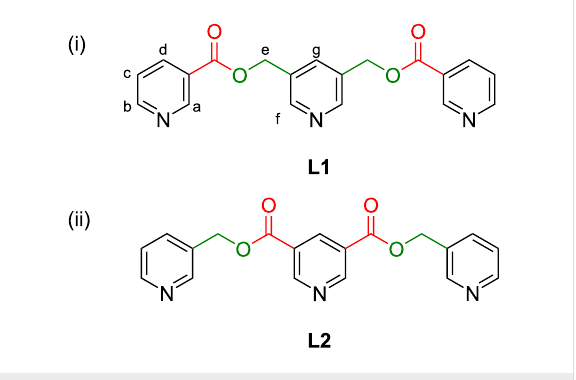
Figure 1: The ligands (i) L1 and (ii) L2 that are positional isomers